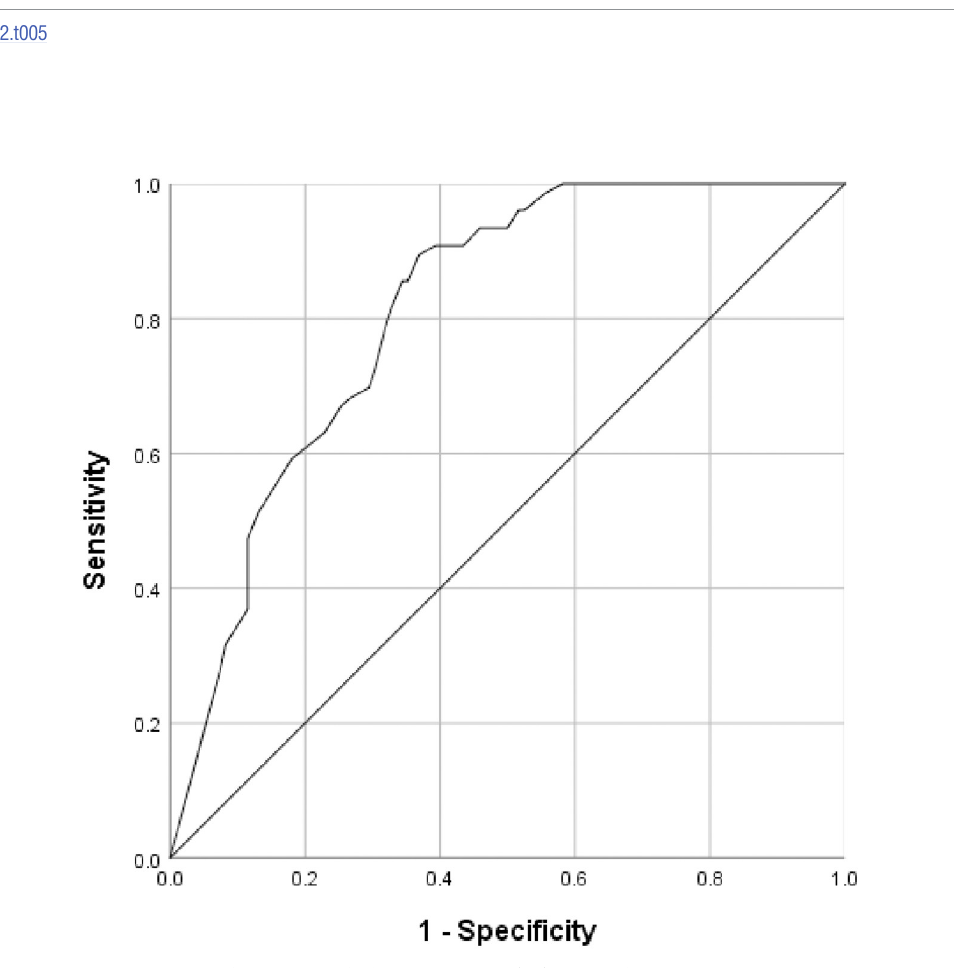
Fig 4. ROC curve for SRS-2 Deaf adaptation T score (T1) against diagnostic